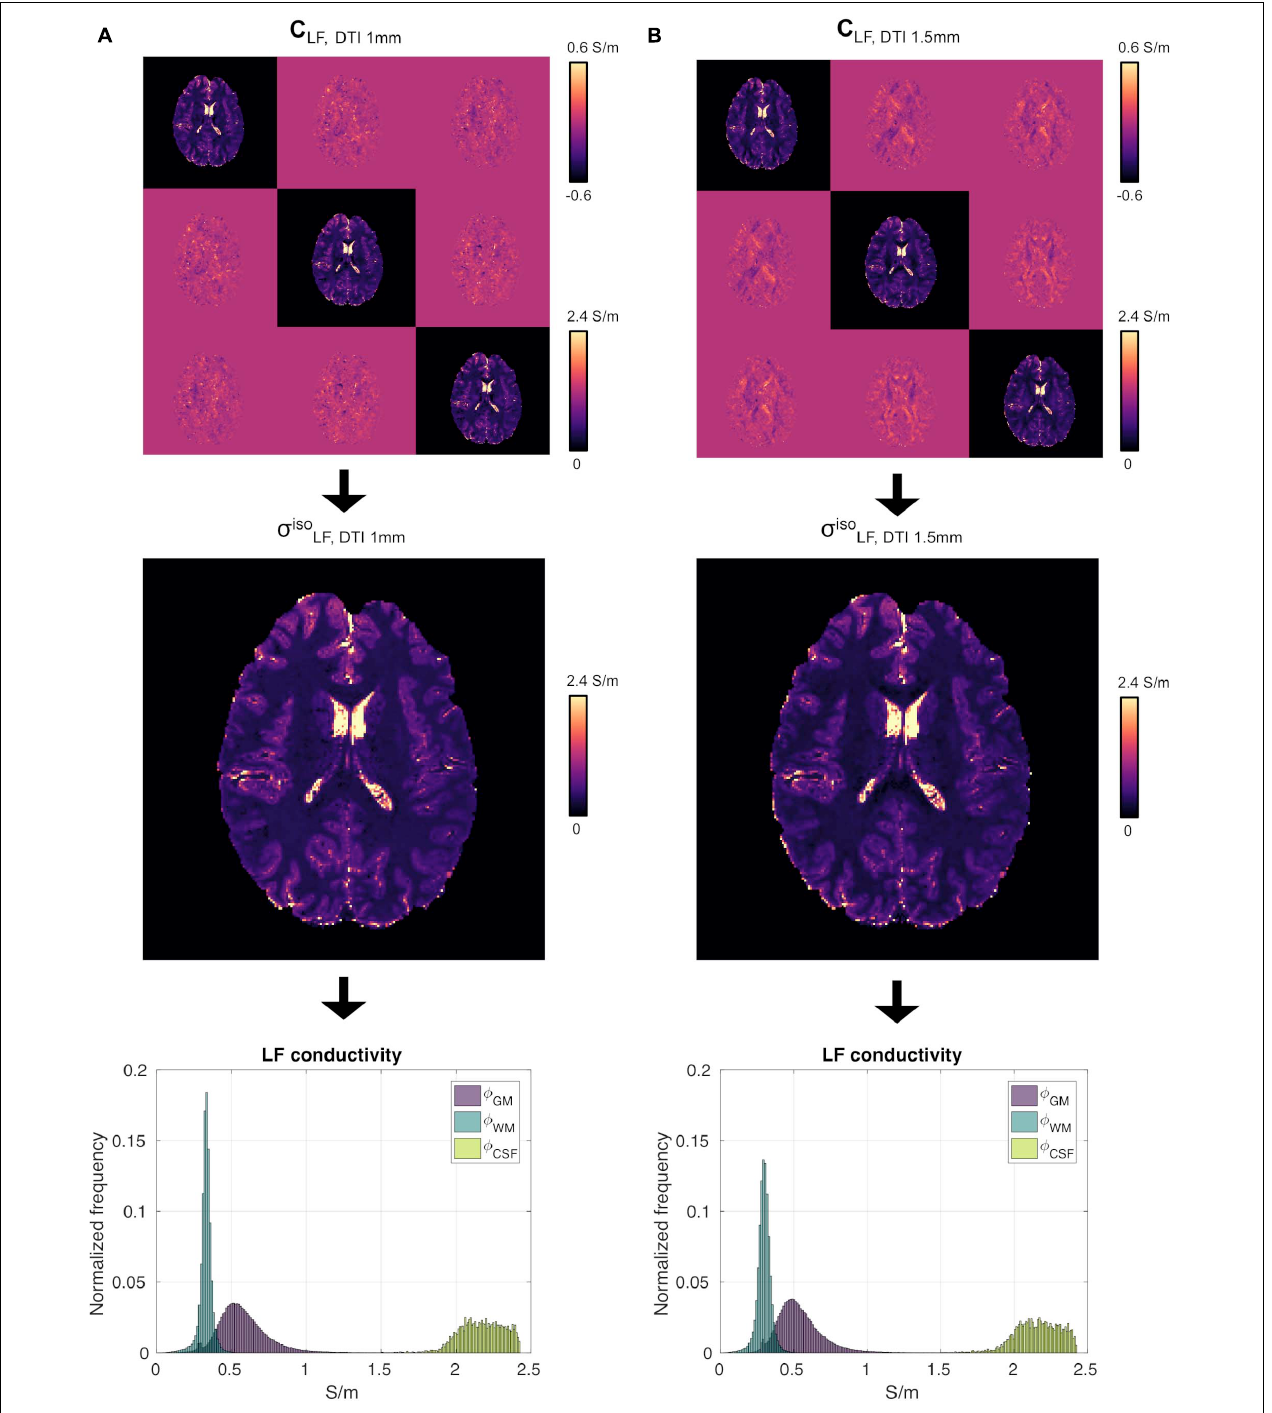
FIGURE 4 | High-resolution experiment on subject S1. (A) C LF (top), σ iso LF (center) and φ GM , φ WM and φ CSF (bottom) reconstructed using the DTI 1 mm protocol. Panel (B) same as (A) using the DTI 1.5 mm protocol